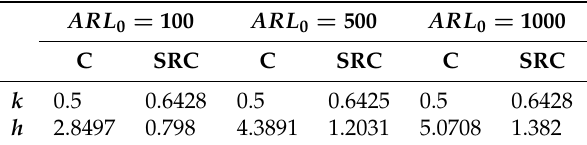
Table 1. Optimal control limits h and reference values k for the parametric cumulative sum (CUSUM) (C) and the conventional sequential ranks CUSUM (SRC) for ARL 0 = { 100,500,1000 } (ARL = average run